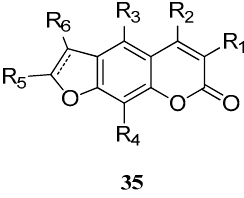
Figure 2. Structure of a series of furanocoumarin derivatives.